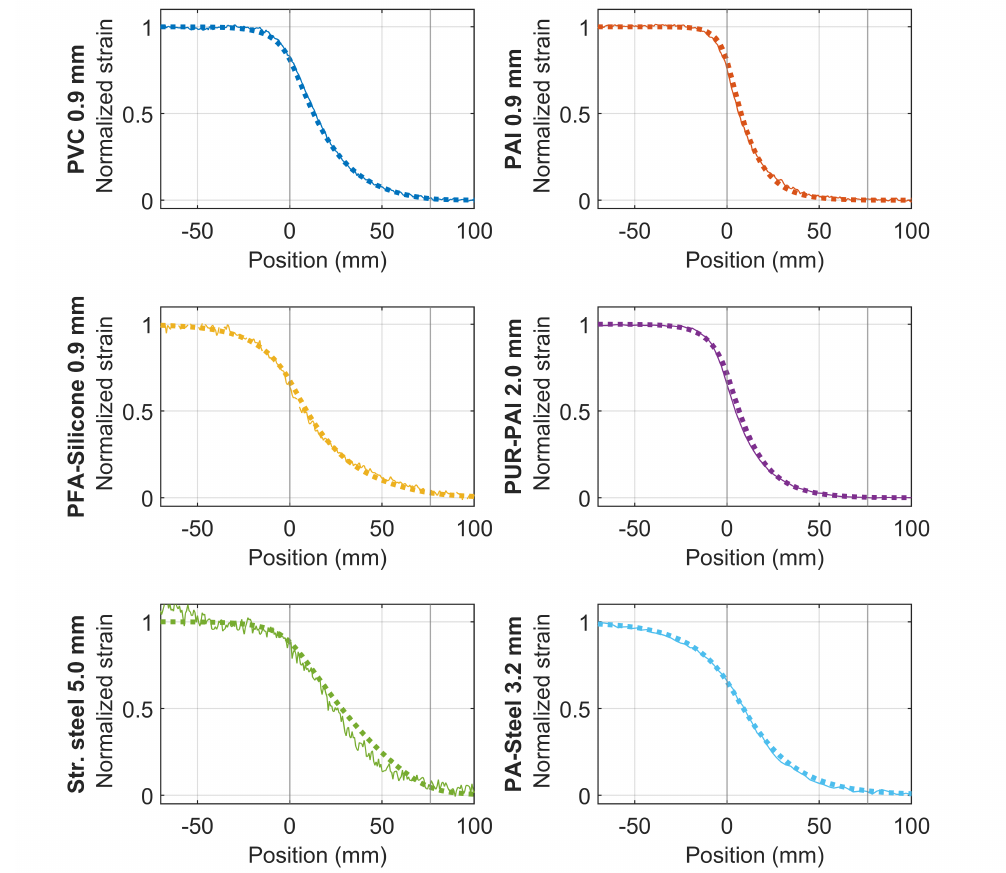
Figure 17. Strain distribution of different cables (solid lines) with comparison to mechanical model (dotted line).